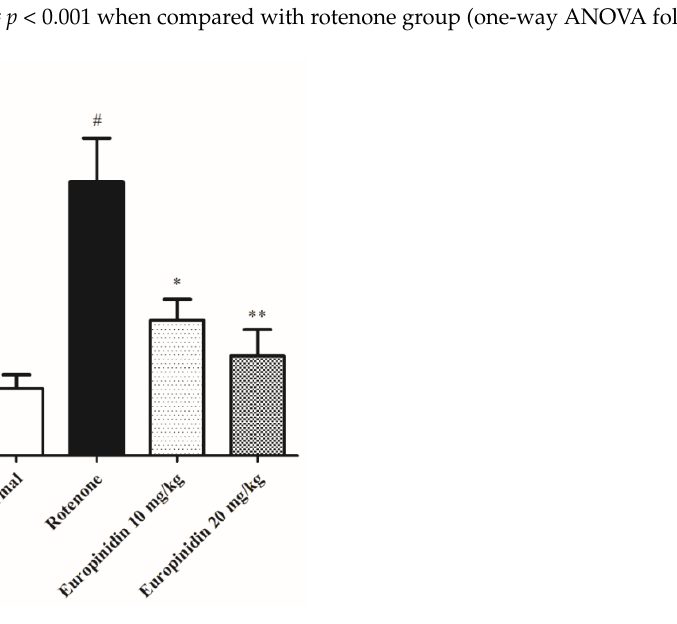
Figure 3. Effect of europinidin on AChE. The data were expressed as mean ± S.E.M. ( n = 6/group). * p < 0.05, ** p < 0.01, when compared with the control group; # p < 0.001 when compared with the rotenone group (one-way ANOVA followed by Tukey’s test).